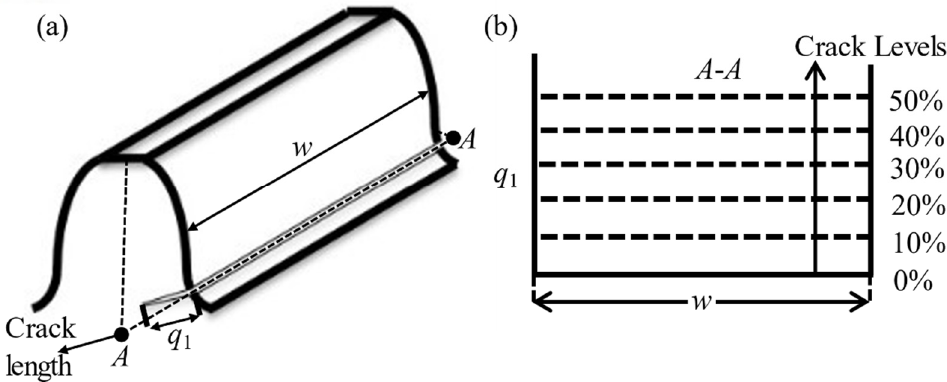
Figure 6. Length and width propagation ( a ) model, ( b ) the related scenario [31]. Table 3. Crack levels and the corresponding length.